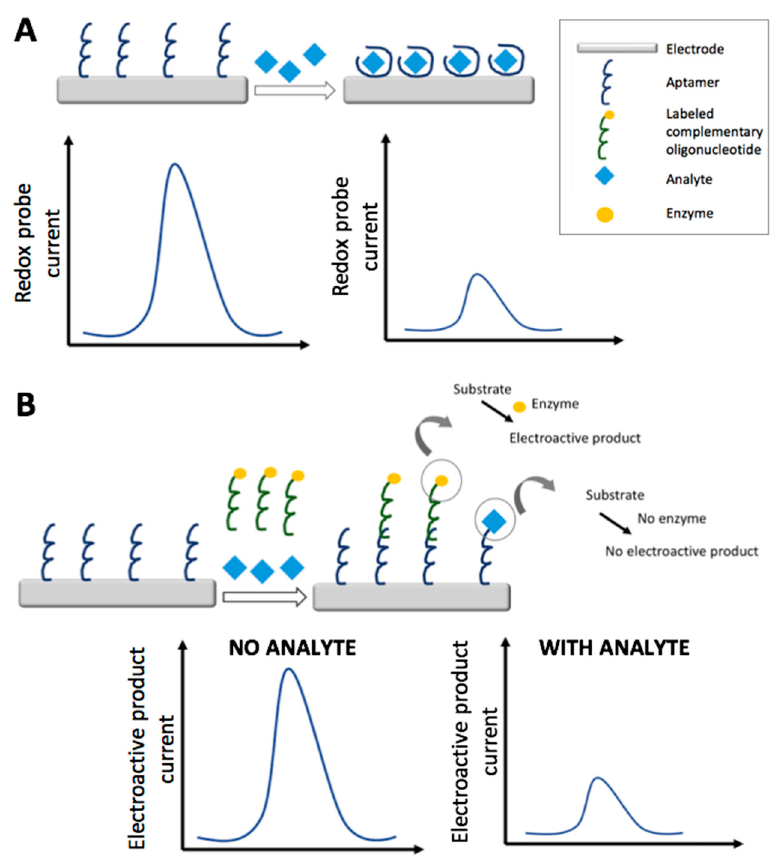
Figure 3. Schematic representation of detection strategies for an electrochemical aptasensor: label free non-competitive detection by the use of a redox probe ( A ); labeled competitive detection exploiting the signal generated by the electroactive product of the reaction catalyzed by an enzyme ( B ). The competition for the aptamer is among the analyte and the labeled complementary oligonucleotide; with the increase of the analyte concentration there is a decrease of the labeled complementary oligonucleotide bound to the aptamer and thus of enzyme and consequently a decrease in the electroactive product signal.